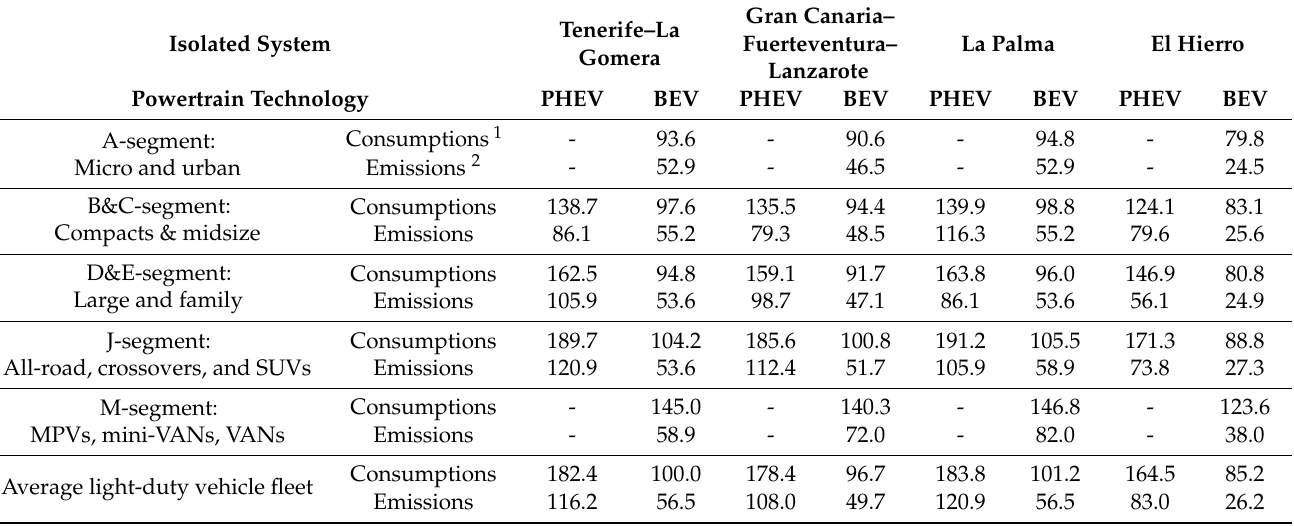
Table 9. The WtW results for PEVs in the PTECan scenarios